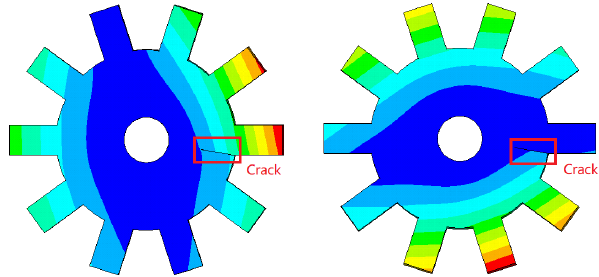
Figure 4. The 1ND mode shapes of a disk with a 56mm